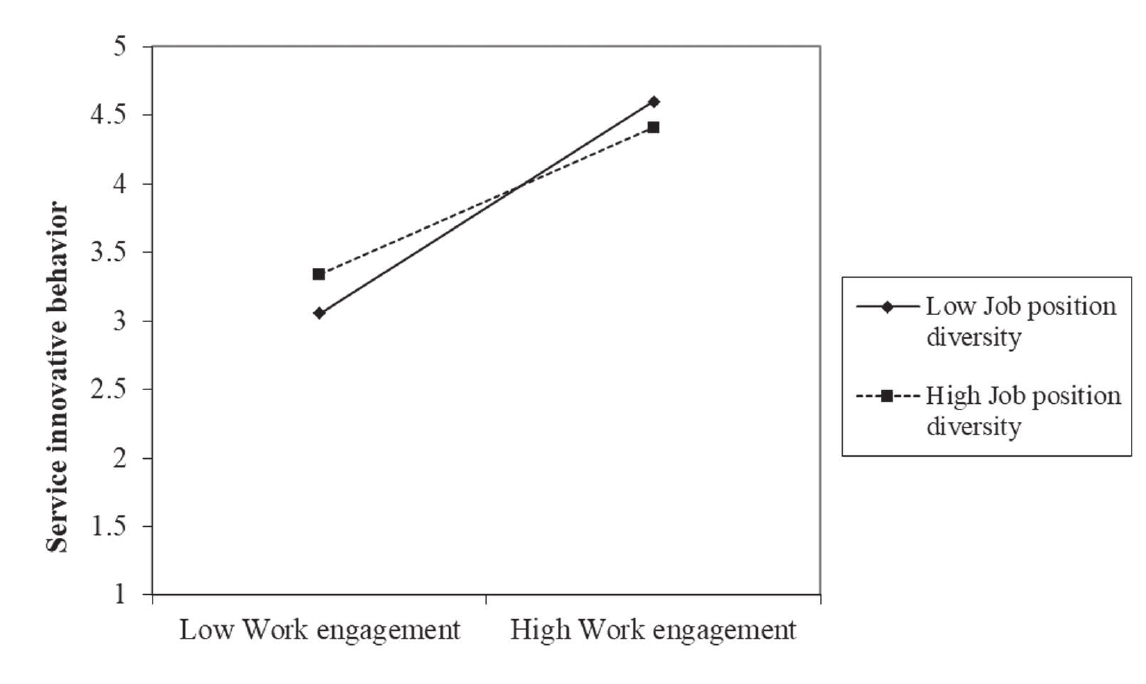
Figure 2. Moderating effect of job position